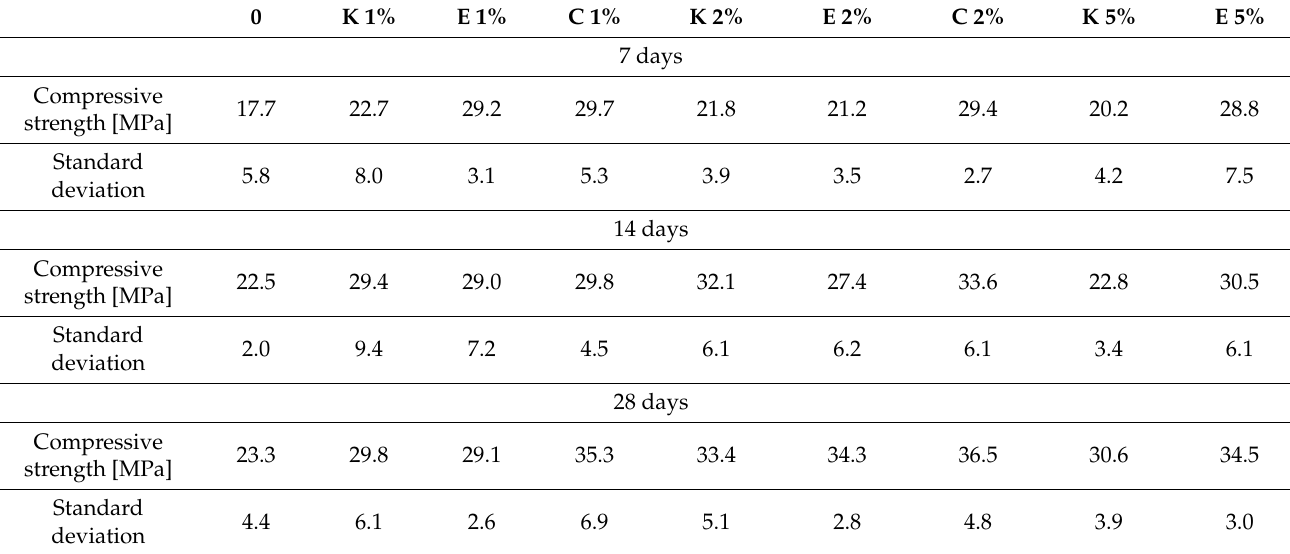
Table 6. Compressive strength—tested geopolymer composites after 7, 14, and 28